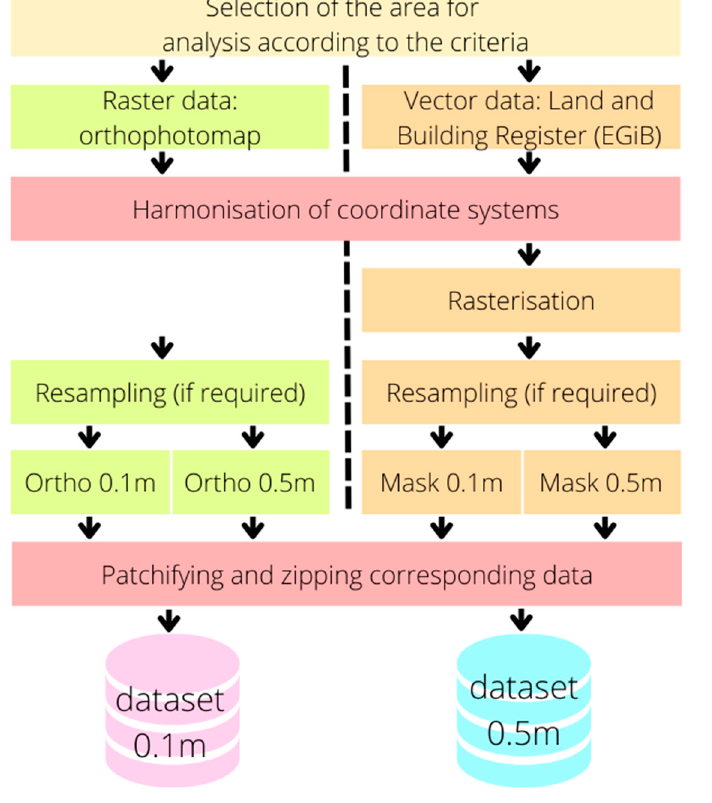
Table 1. Summary of created datasets.